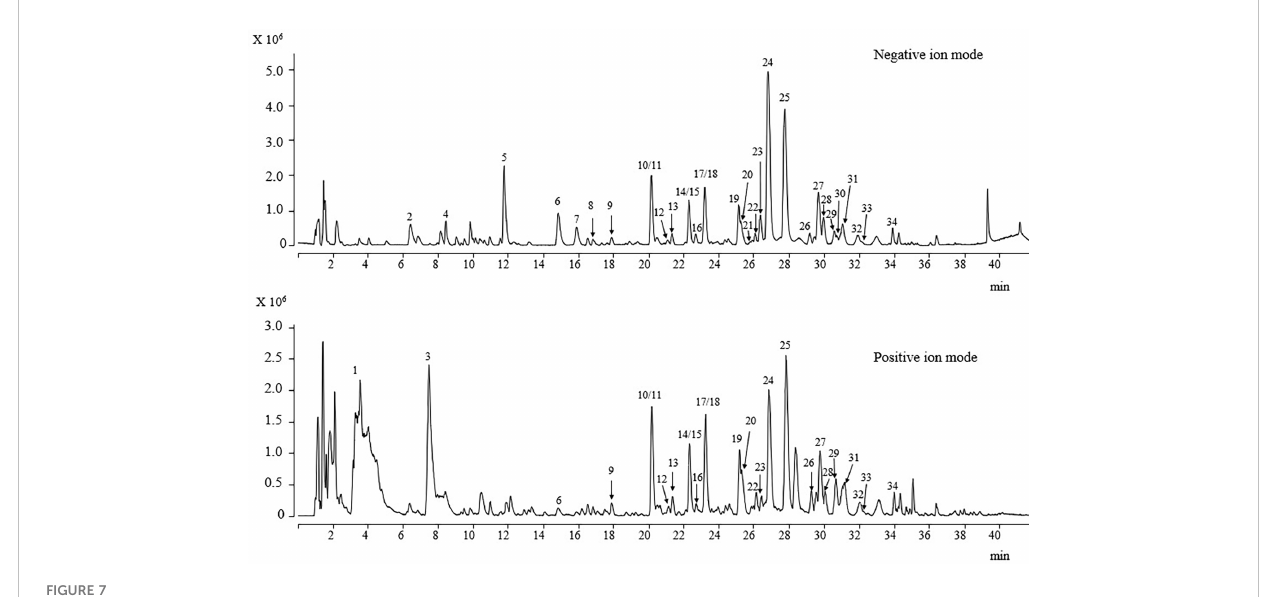
FIGURE 7 UPLC-ESI/MS/MS total ion chromatogram of